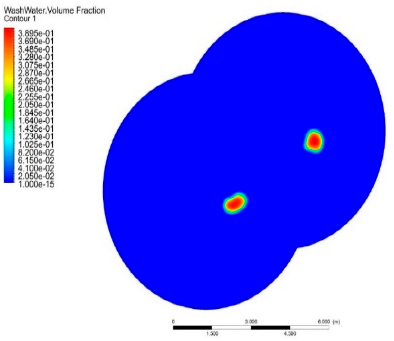
Figure 7. Maximum Volume Fraction values for the Scrubber Wash Water (refined mesh).